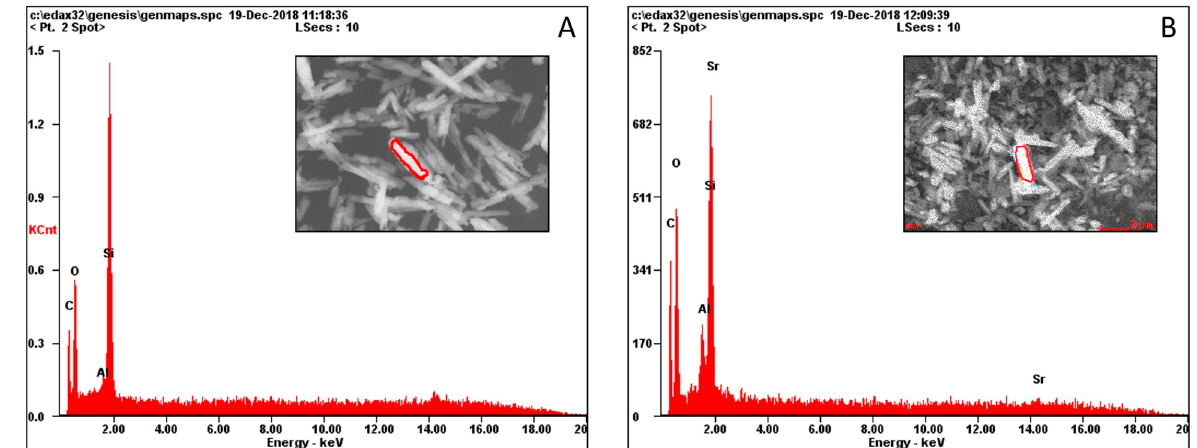
Figure 4. ( A ) The quantitative elemental analysis of the area selected in the inserts in Figure 4A,B. SrHNT shows the wt.% of carbon [C], aluminum [Al], silicon [Si], and oxygen [O] of HNT. The peak of Si is clearly seen. ( B ) The quantitative elemental analysis of the area selected in the inserts (4A) HNT and (4B) SrHNT show the wt.% of carbon [C], aluminum [Al], silicon [Si], oxygen [O], and strontium [Sr] of SrHNT.